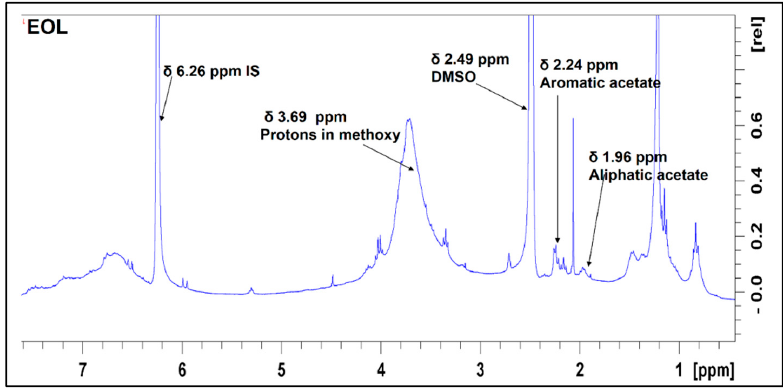
Figure 2. 1 H NMR spectra of lignin isolates (MWL, ILL and EOL) revealing acetate of varying intensity.